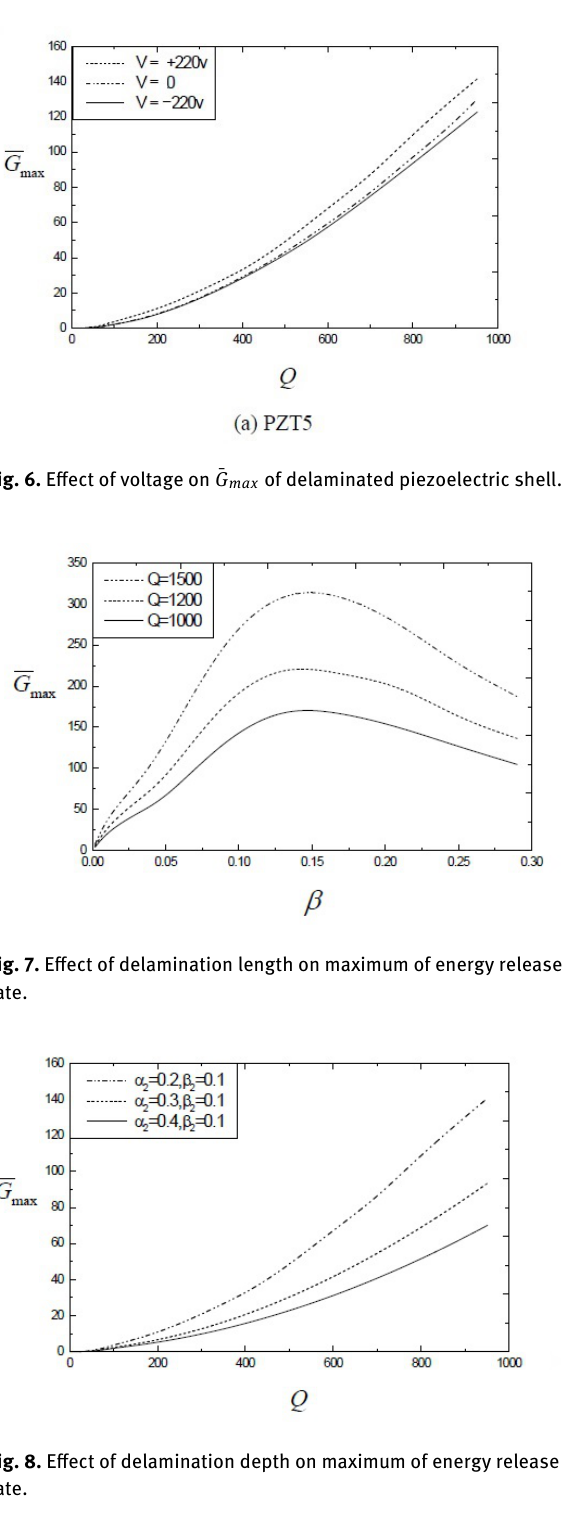
shell. The mechanical load is taken as Q = 1000 and the voltage V = 0. As can be seen, the maximum of energy re- lease rates increases with the increase of temperature and humidity. In addition, it can be seen that the energy